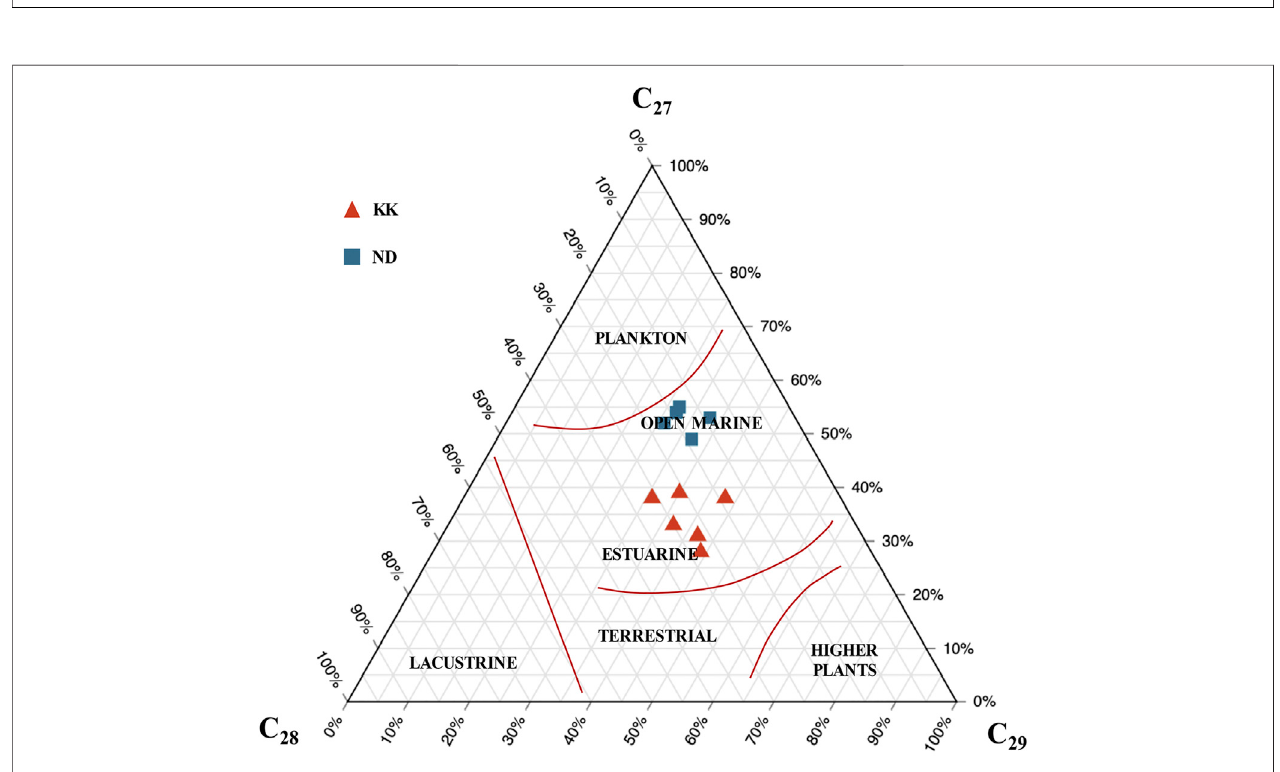
Frontiers in Earth Science |